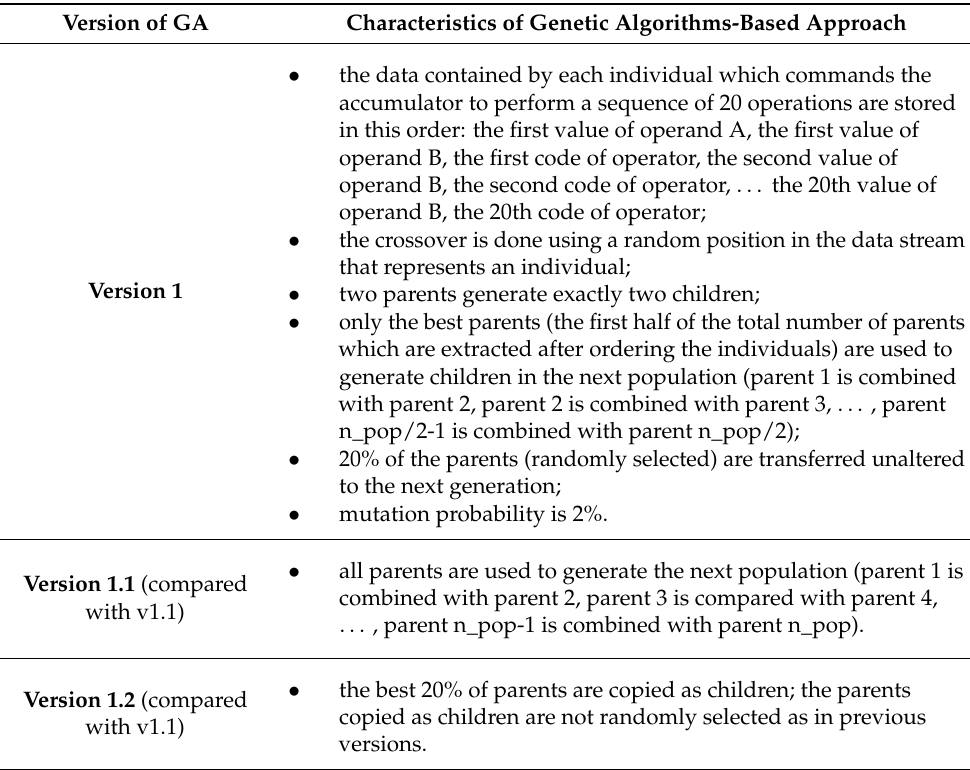
Table 1. The characteristics of genetic algorithm-based approaches developed in the present